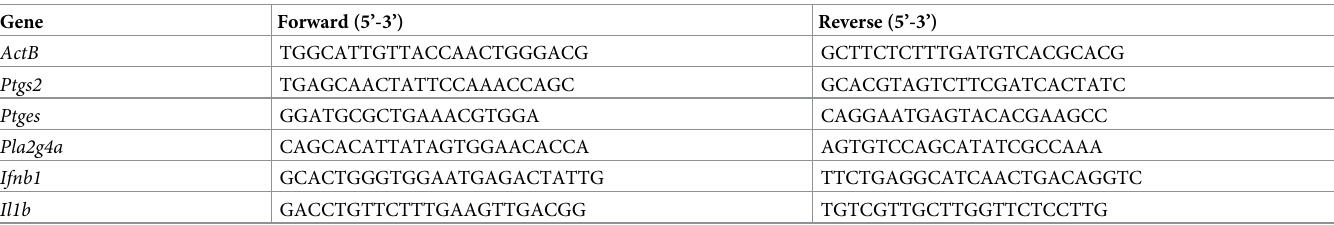
Table 2. qRT PCR